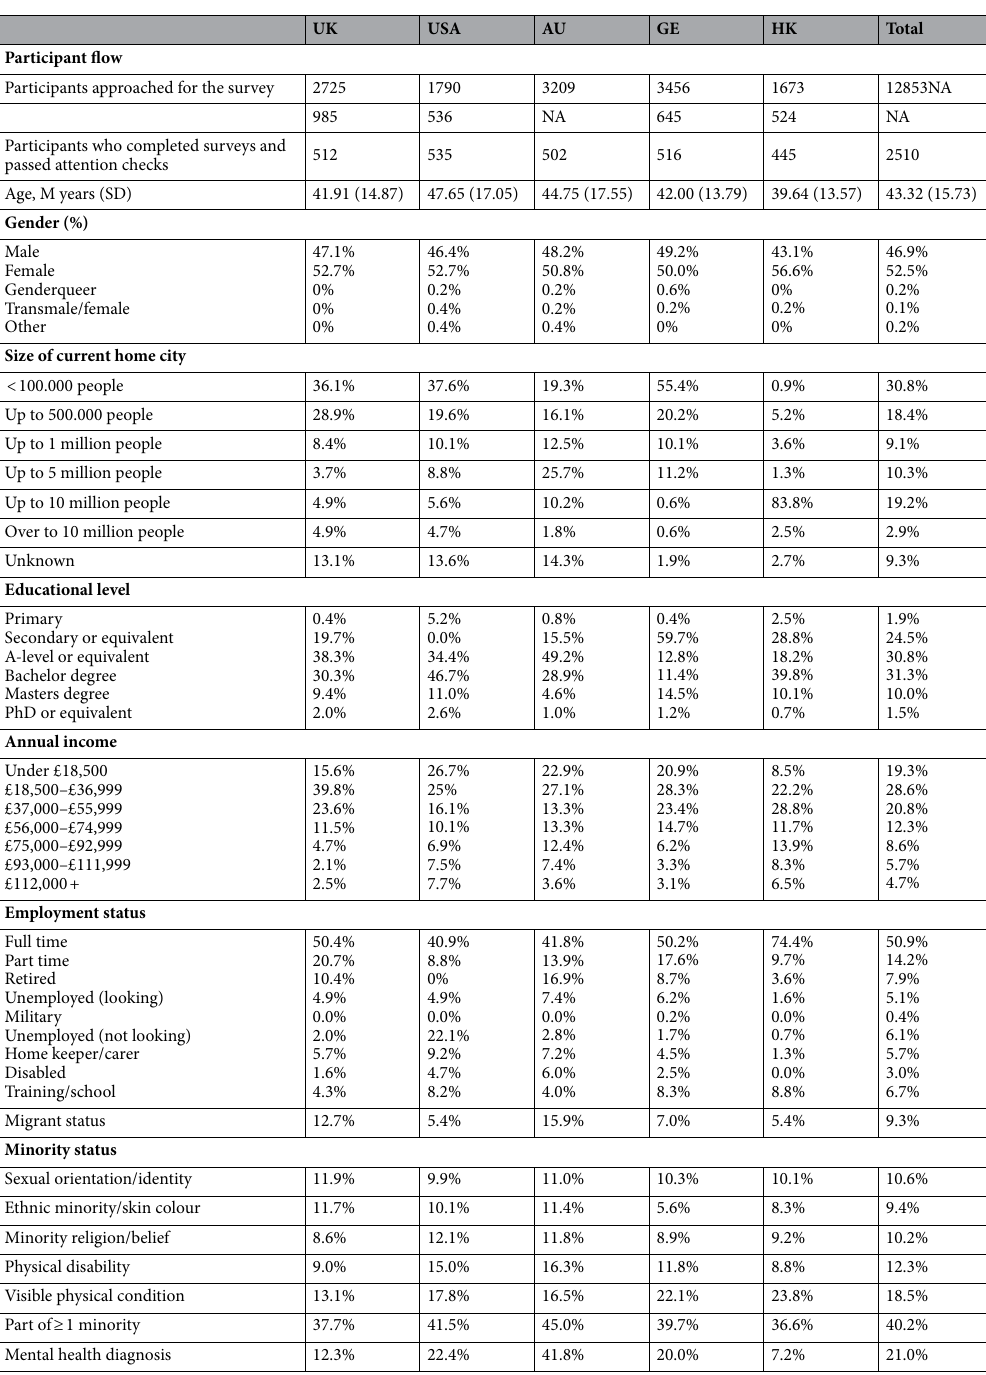
Table 1. Participant flow and sociodemographic details across samples. An overview of the descriptive values for the remaining predictor variables can be found in supplement